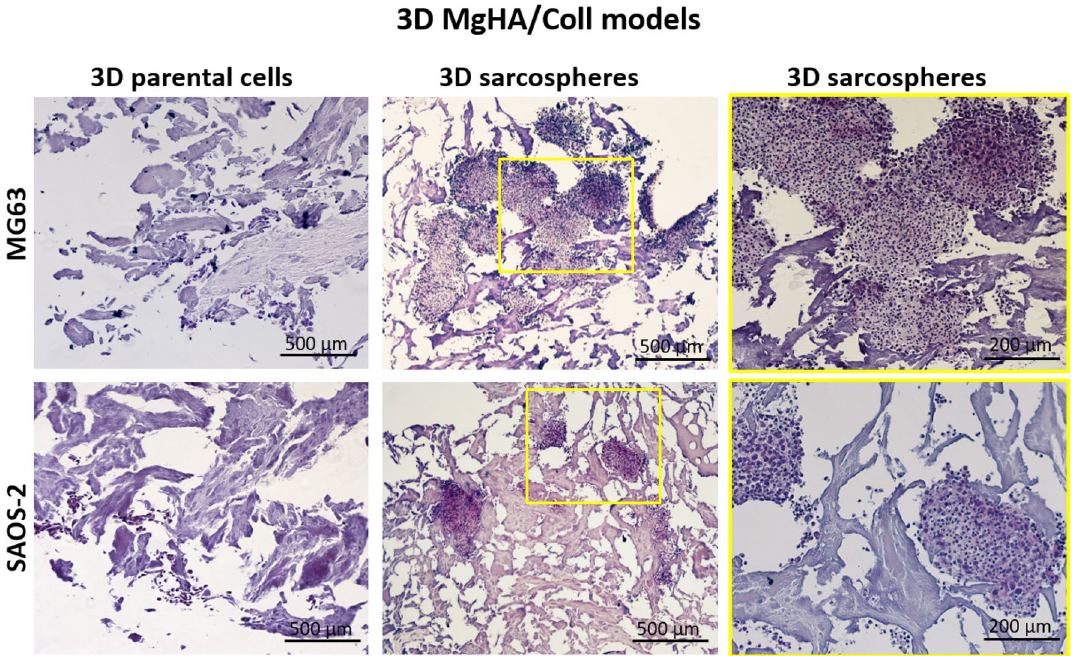
Figure 3. Histological analysis of the 3D MgHA/Coll scaffolds with both MG63 and SAOS-2 cells. The images highlight the morphological features and the interaction behaviour of the sarcospheres and parental cells with the MgHA/Coll material. On the right, it is possible to observe an image enlargement of 200 µm of the spheroidal phenotype of the